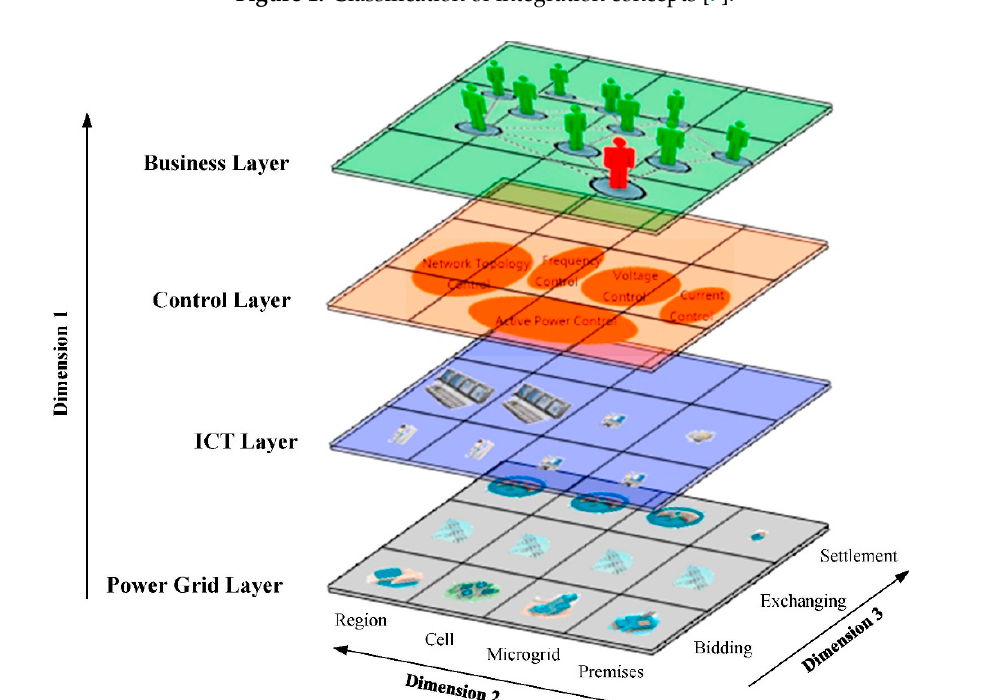
Figure 2. The four-layered system architecture of P2P energy trading from [10].